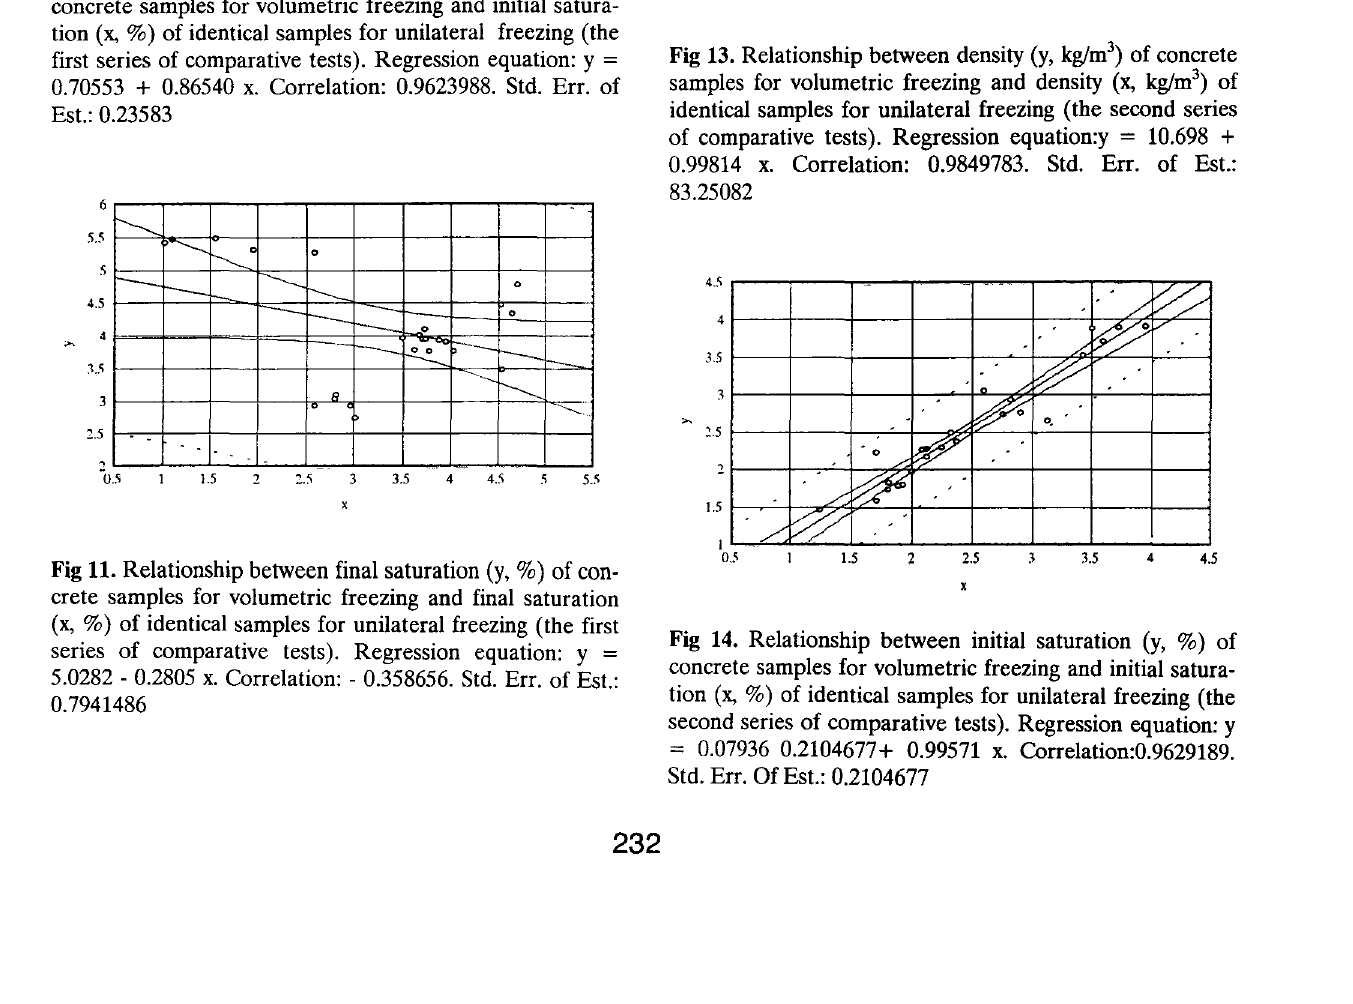
Fig 14. Relationship between initial saturation (y, %) of concrete samples for volumetric freezing and initial satura tion (x, %) of identical samples for unilateral freezing (the second series of comparative tests). Regression equation: y = 0.07936 0.2104677+ 0.99571 x. Correlation:0.9629189. Std. Err. Of Est.: